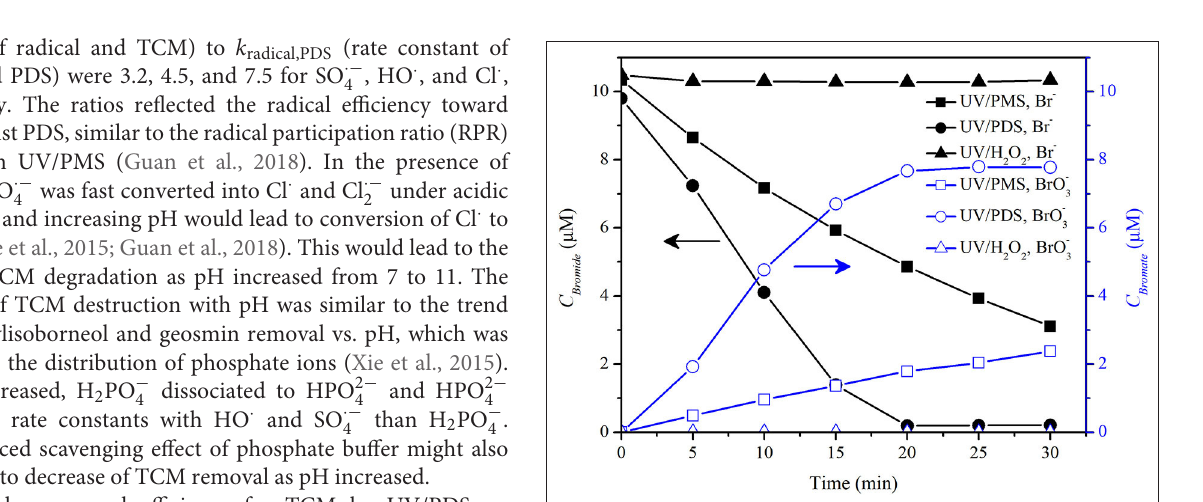
FIGURE 6 | Degradation efficiencies of TCM by UV/PMS, UV/PDS, and UV/H 2 O 2 (A) at pH 3, (B) at pH 7, and (C) at pH 11. Conditions: 0.6L, I 0 = 1.7 × 10 − 6 Einsteins · s − 1 , [PB] = 5mM, [TCM] = 2.1 µ M, [PMS] = 0.5mM as 1/2 Oxone, [PDS] = 0.5mM, [H 2 O 2 ] = 0.5mM, 25 ◦ C.